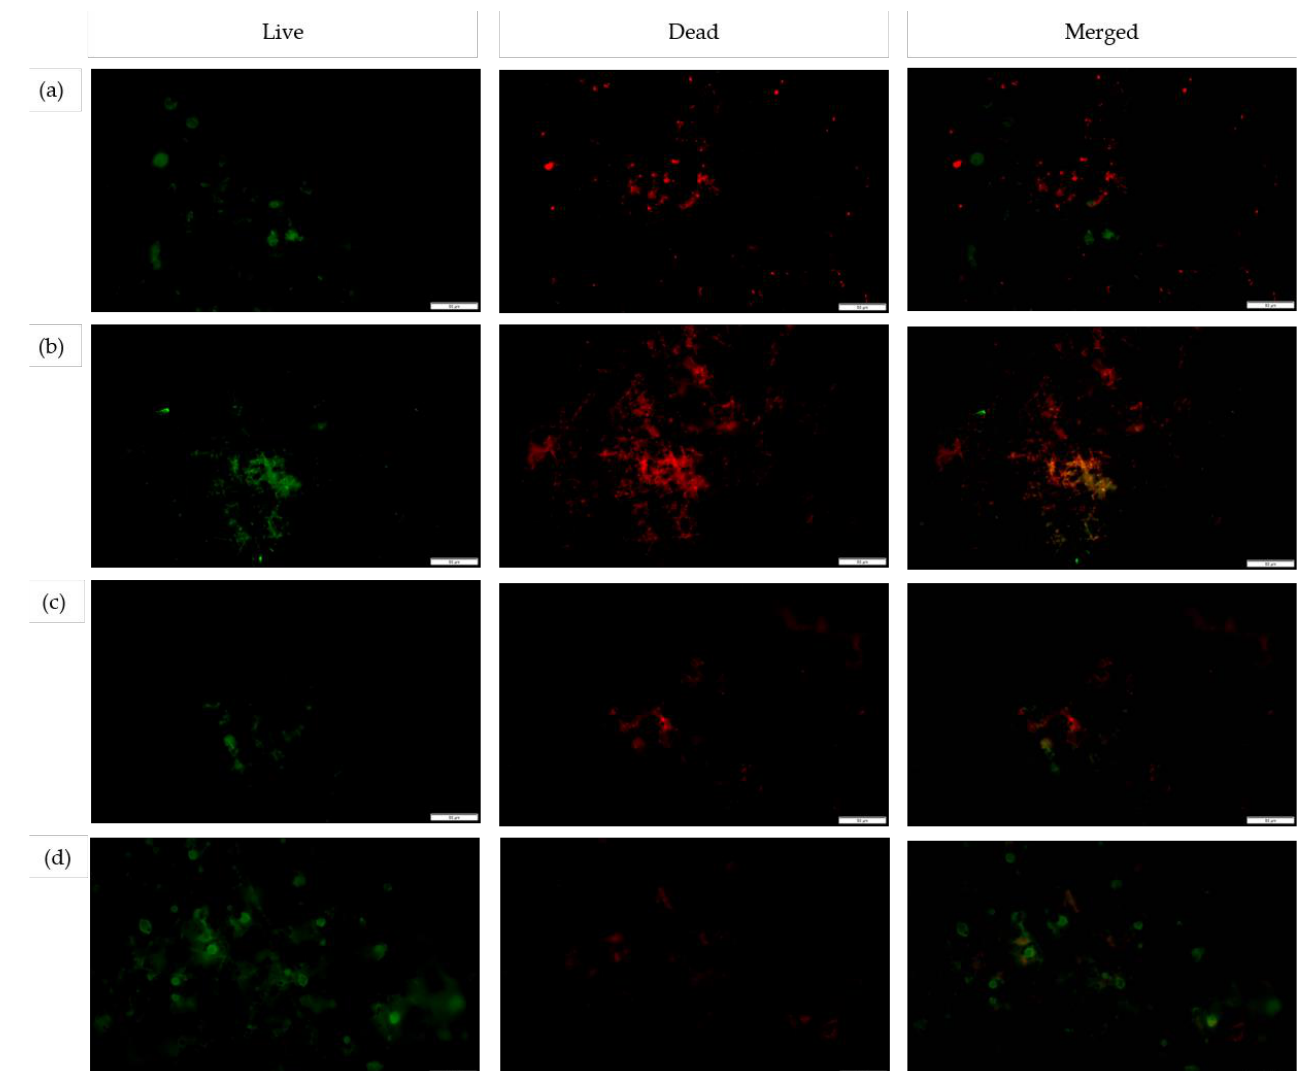
Figure 10. Fluorescence microscopy images of E. coli attachment on ( a ) PGO; ( b ) PGO-M1; ( c ) PGO-M2; and ( d ) PGO-M3 nanofibers at 40× magnification (scale bar: 50 µm). The positively charged PGO-M1 strongly attracted the negatively charged S. aureus